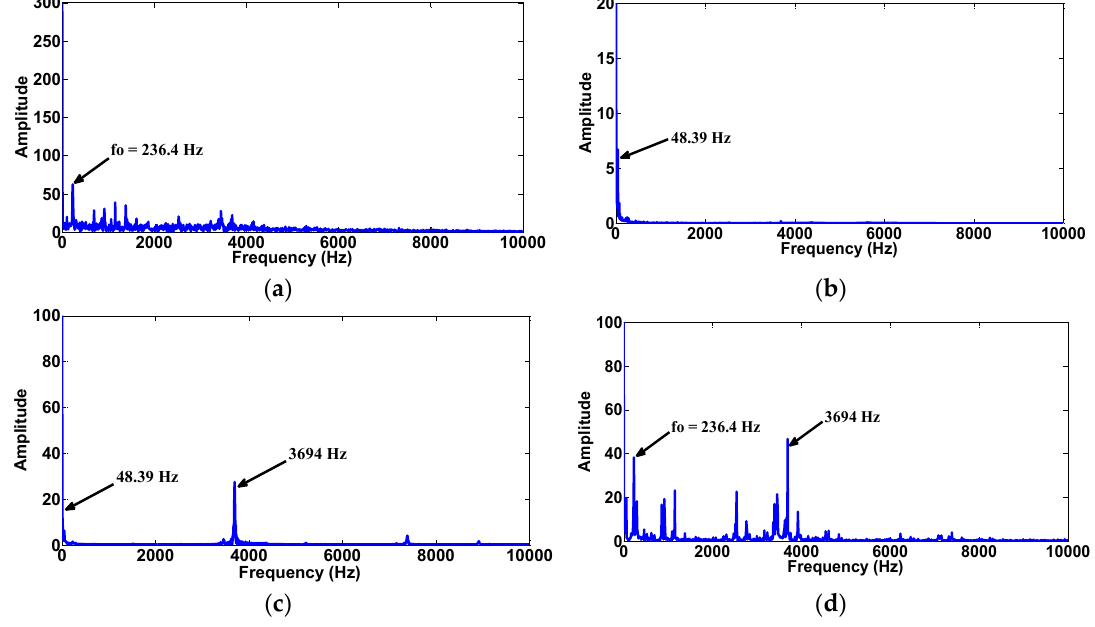
Figure 8. The envelope spectrum of the early outer race faults in bearing 1: ( a ) Original faulty signal; ( b ) De ‐ noised faulty signal based on MPODSOISE and MPOCSOISE; ( c ) De ‐ noised faulty signal by MMBDSOICE; ( d ) De ‐ noised faulty signal by MMBCSOICE.